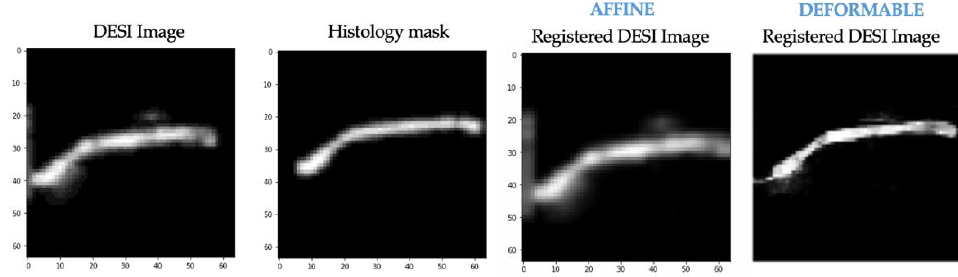
Figure 12. After training experiment 1. Left to right—DESI image (moving), histology masks (fixed), transformed DESI image (moved)—affine transformation, transformed DESI image (moved)—deformable transformation.